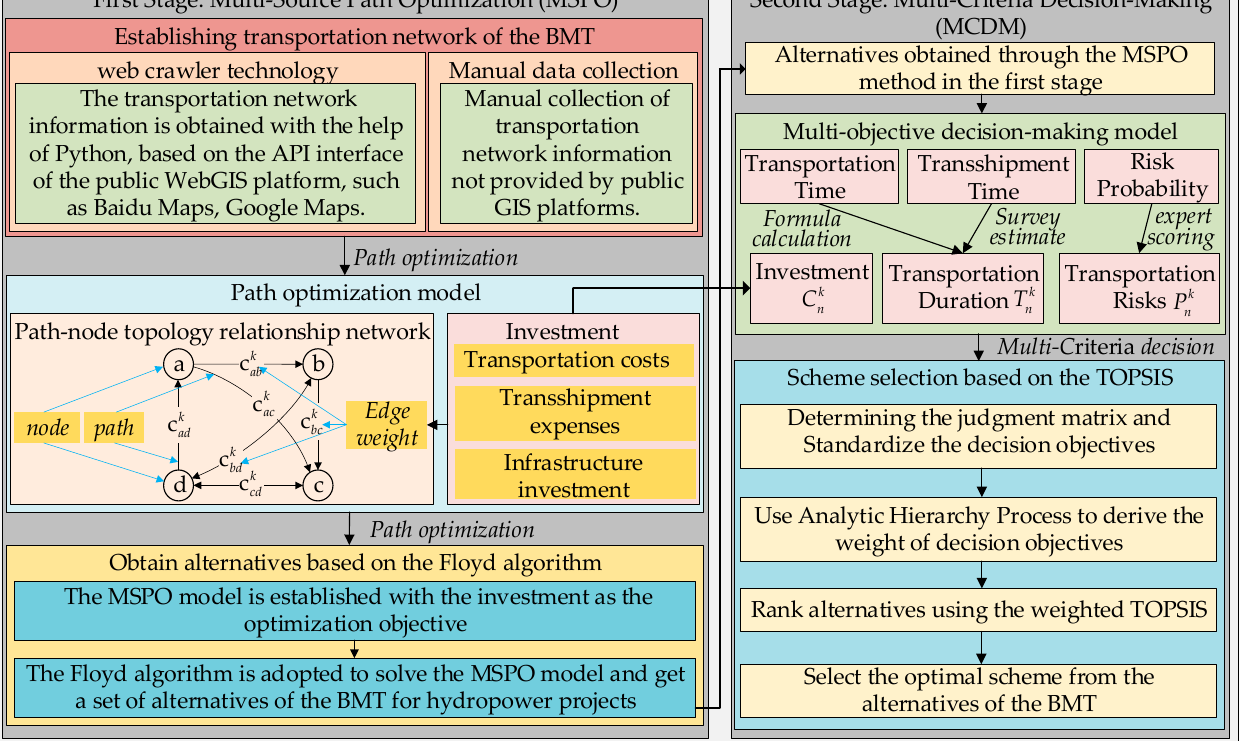
Figure 3. The technical process of web crawler technology based on WebGIS.